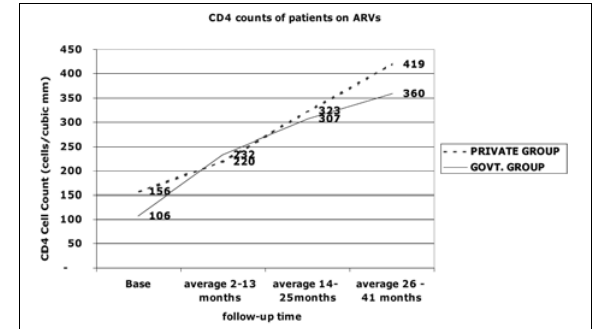
Fig. 4. Comparison of change in CD4 cell count (cells/µl) in the private group versus the government